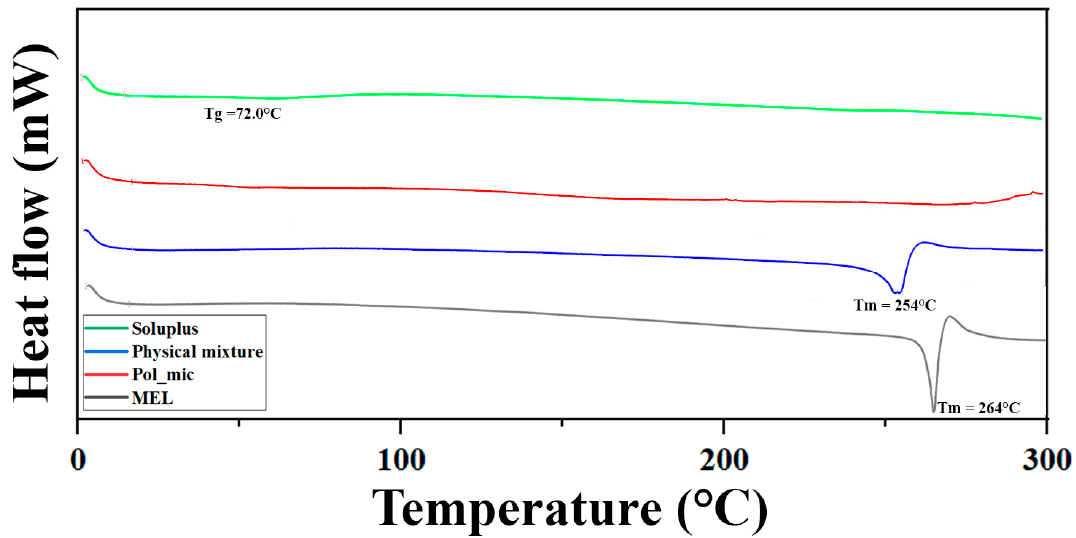
Figure 6. Differential scanning calorimetry (DSC) curves of the components and the